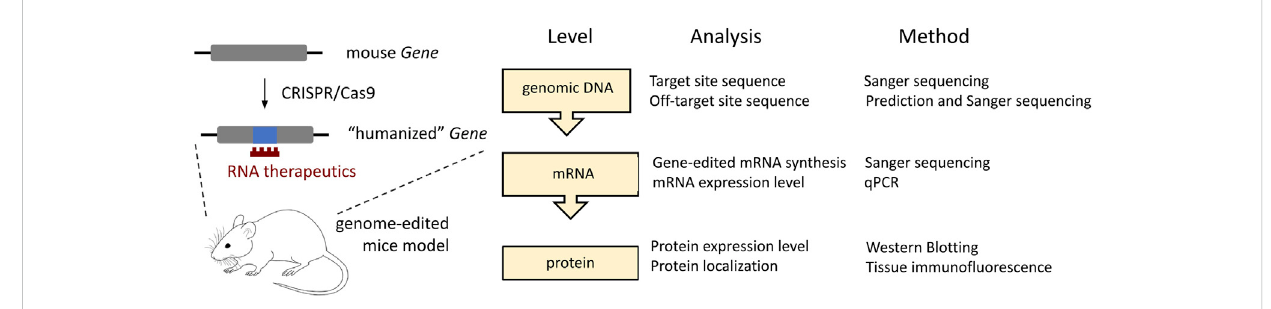
FIGURE 6 The minimal requirement for the gene analysis following CRISPR/Cas9-mediated editing of the protein-coding targets in mice. In the current studies, such analysis is applied to the Gnao1-GGA